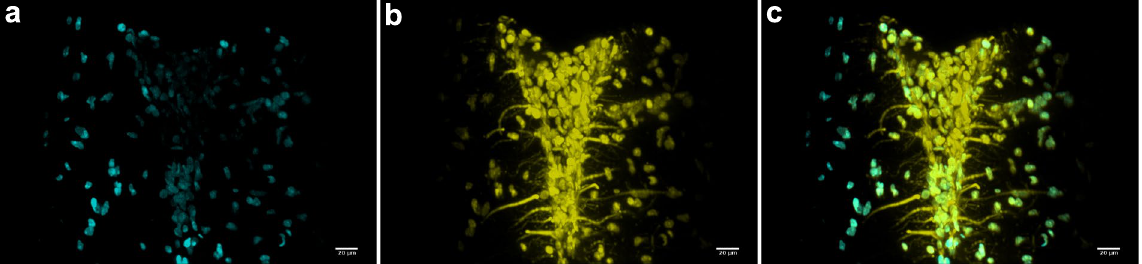
Figure 6. Maximum intensity projections of light sheet image stacks of a thin sagittal slice of fixed rat brain with Alexa Fluor 568 NCAM-immunolabelled axons imaged in two photon mode using M-Squared Sprite-XT laser. ( a ) DAPI channel, ( b ) Alexa Fluor 568 channel, ( c ) Composite image. Scale bars 20 μ m. See Supplementary Videos 4 and 5.